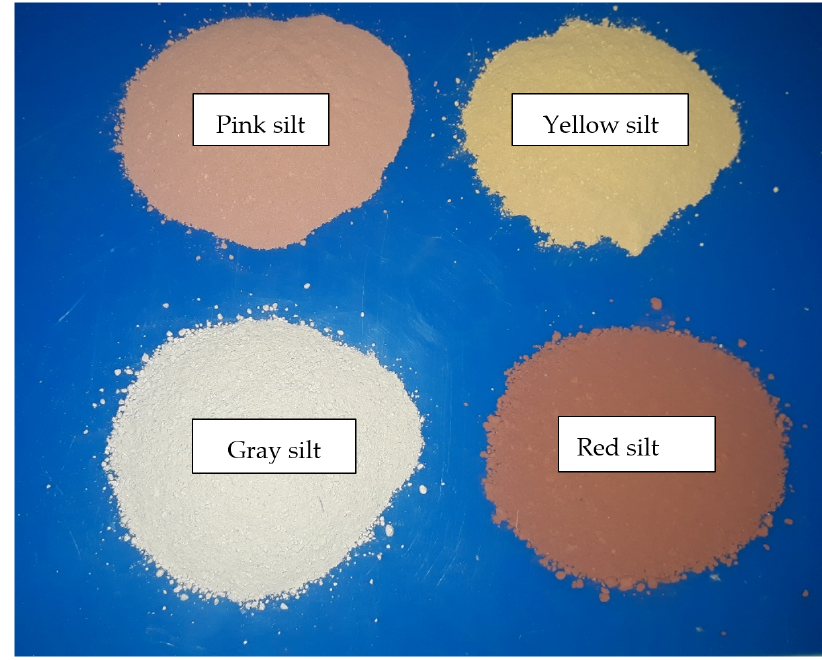
Figure 1. Appearance and color of the silts used in this